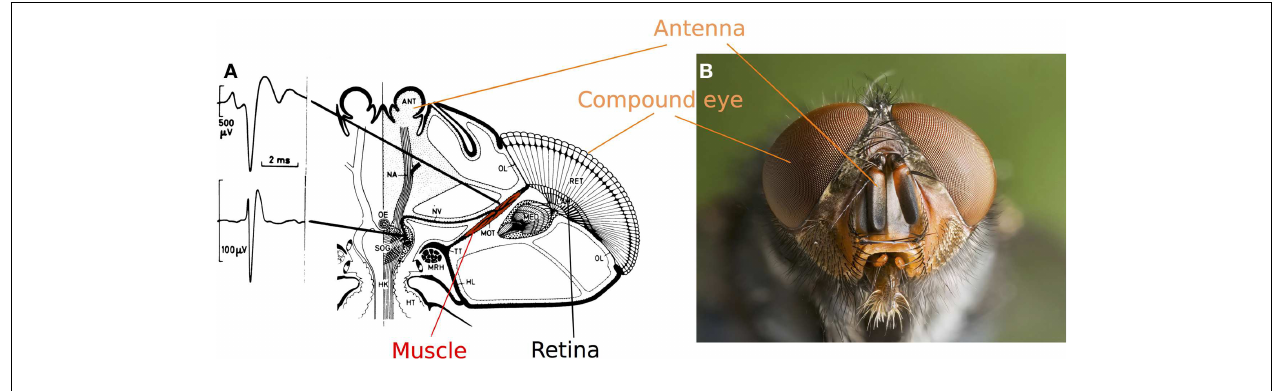
one by the MOT) show that extracellular recordings can be used to record the activity of this muscle. Adapted from (Hengstenberg,